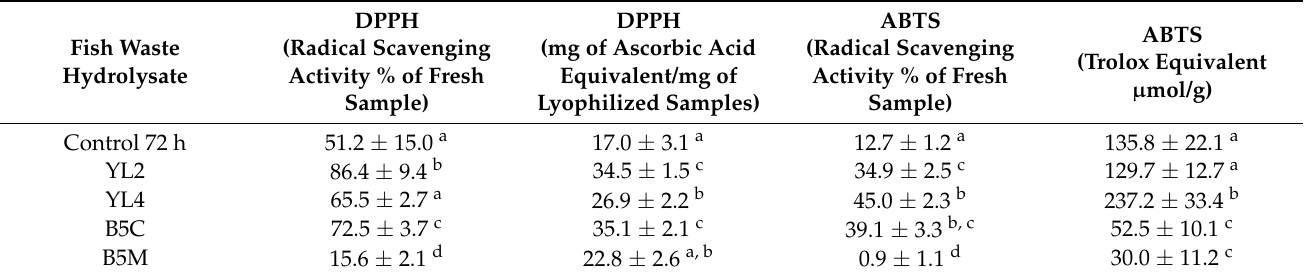
Table 2. Antioxidant activity of the different fish waste hydrolysates. Results are the average of three replicates ( n = 3).